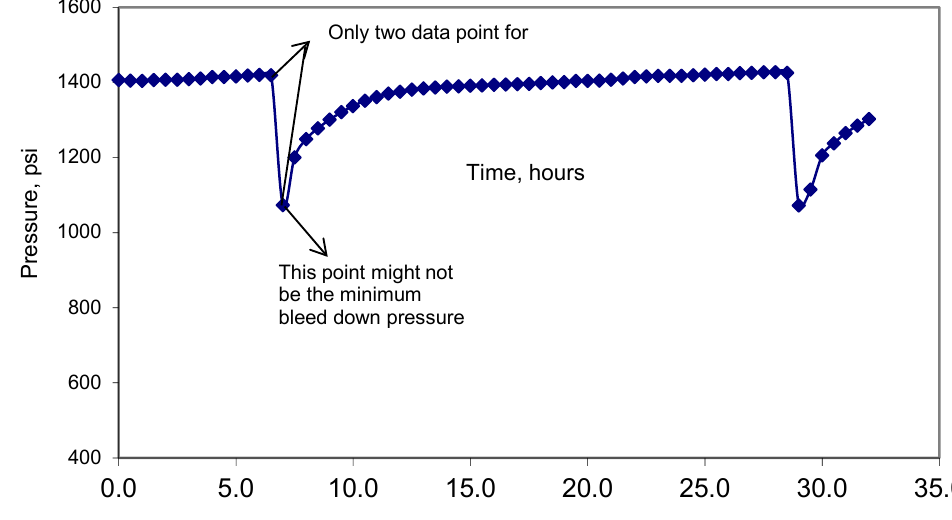
Figure 14. Casing pressure test results of well APTA-31.